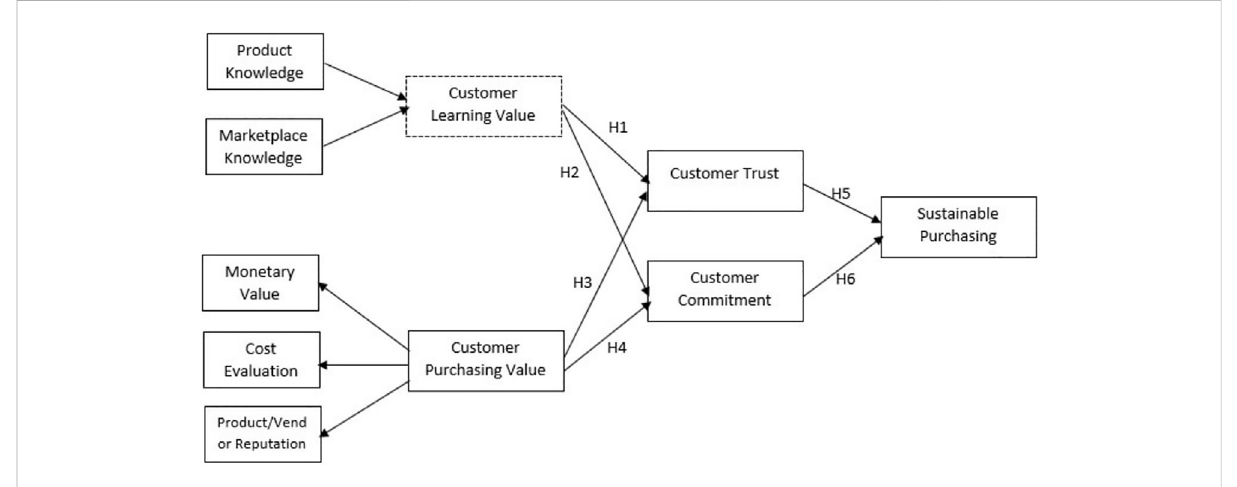
FIGURE 1 Research framework and